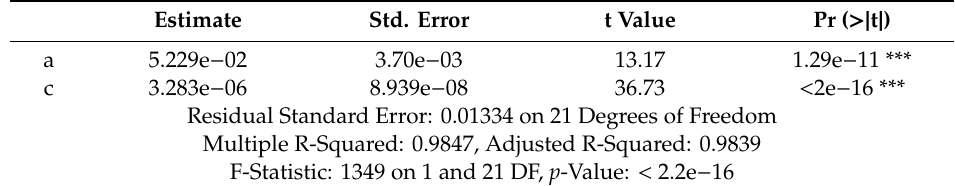
Table 7. Statistical parameters for the quadratic regression model.